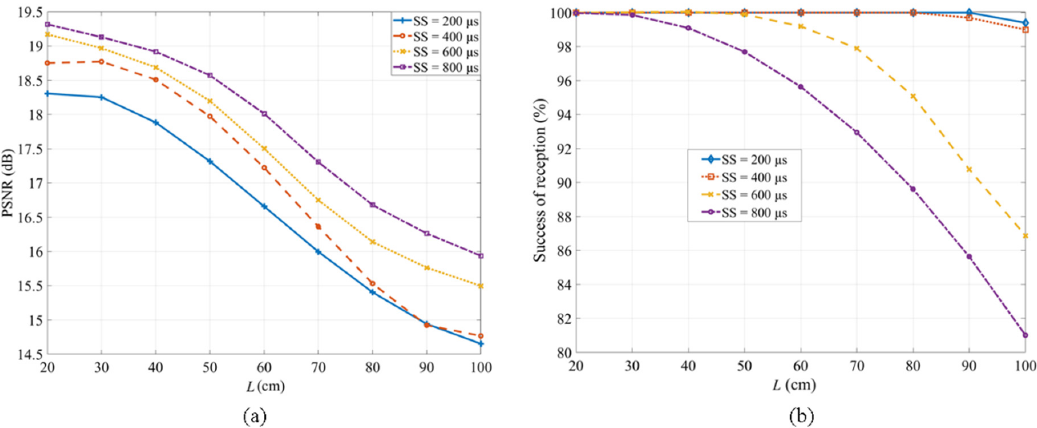
Figure 11. MIMO-OCC performance analysis: ( a ) the peak signal-to-noise ratio (PSNR); and ( b ) the Figure 11. MIMO ‐ OCC performance analysis: ( a ) the peak signal ‐ to ‐ noise ratio (PSNR); and ( b ) the percentage success of received bits with respect to L percentage success of received bits with respect to L .